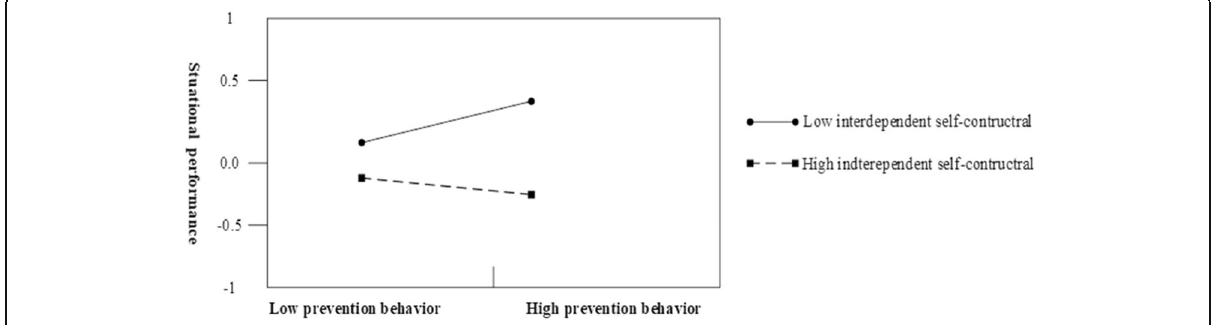
Fig. 8 Moderating effect of interdependent